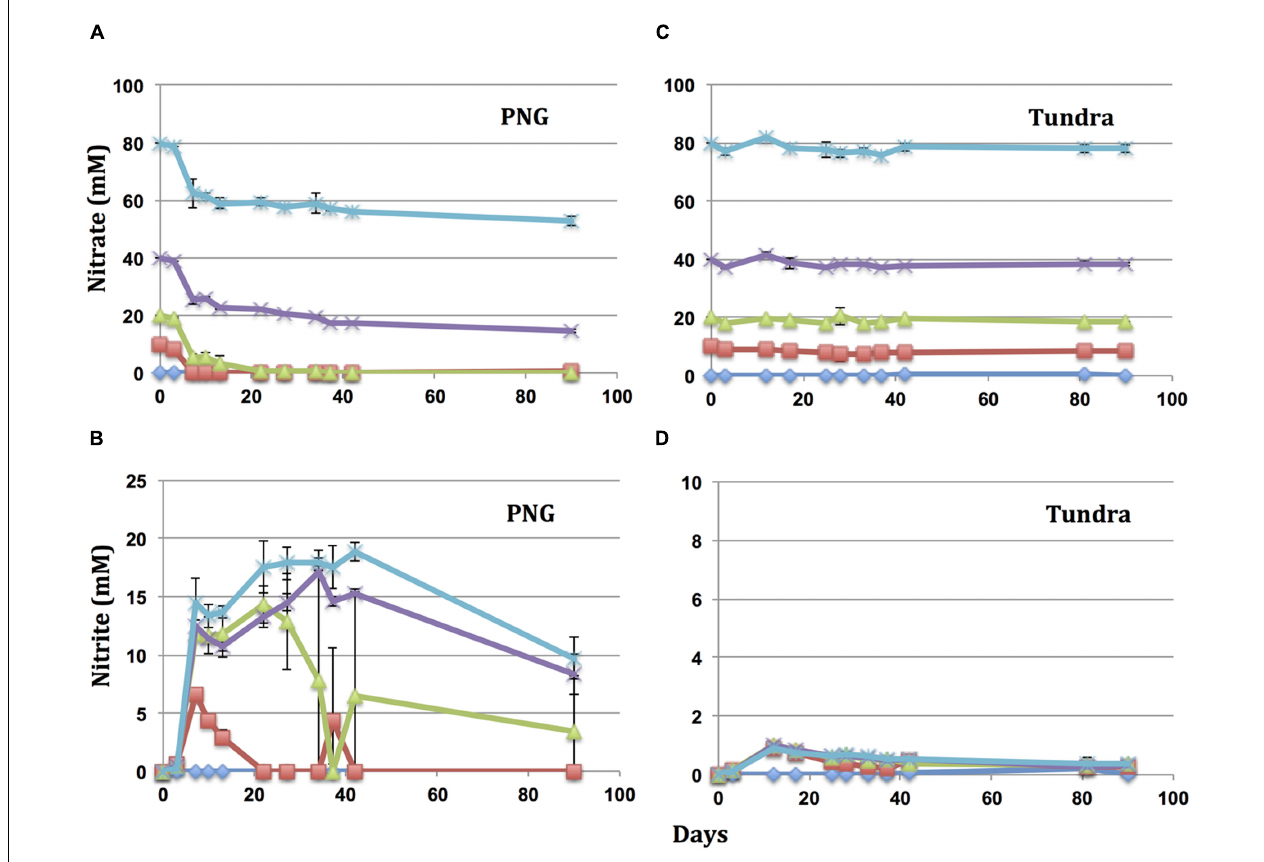
FIGURE 2 | Reduction of nitrate and formation of nitrite as a function of time in microcosms with PNG oil (A,B) and Tundra oil (C,D) . All microcosms were inoculated with a 10% (v/v) inoculum of produced water from 18PW in the MHGC field. The initial nitrate concentrations were 80 ( ∗ ), 40 ( × ), 20 ( (cid:78) ), 10 ( (cid:4) ), or 0 ( (cid:7) ) mM. Error bars represent the standard deviations for four